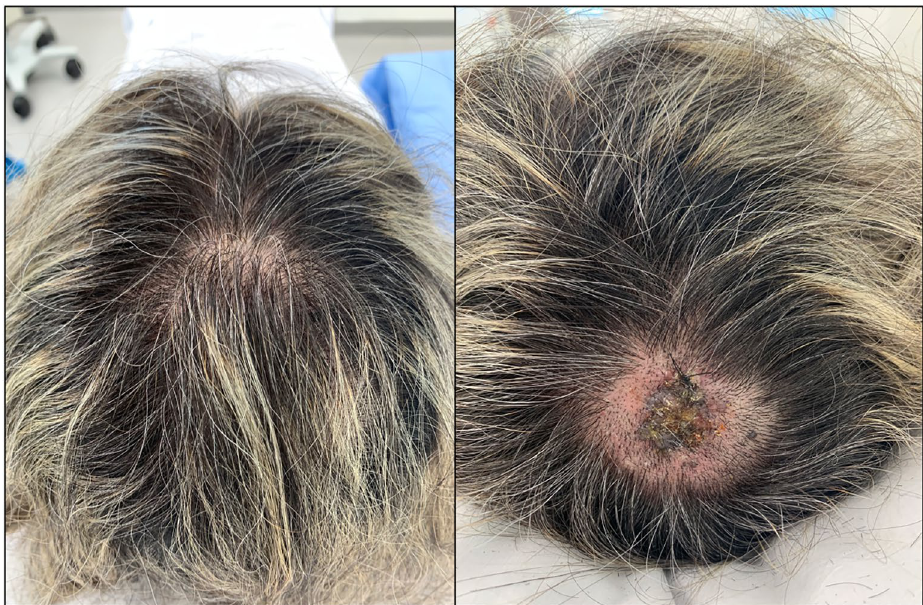
Figure 1. Clinical image of a 57-years-old woman with a melanoma hidden by hair, without androgenetic alopecia or chronic sun damage. Histopathological examination showed a superficial spreading melanoma, with a Breslow thickness of 7.1 mm, without elastosis or signs of androgenetic alopecia.